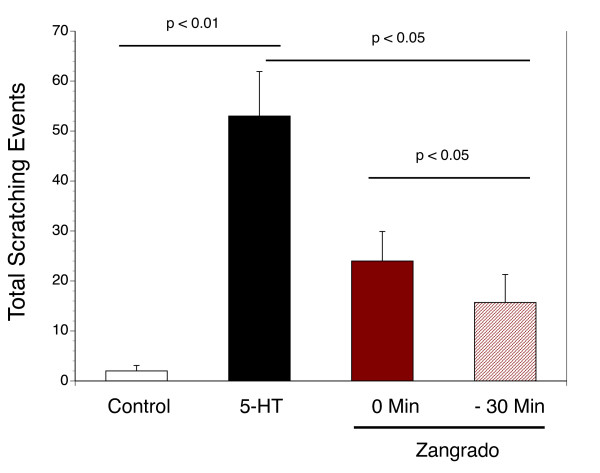
Effects of Zangrado on 5-HT evoked scratching: Comparison between pretreatment and immediate post-treatment. Scratching episodes in response to saline injection (control, n = 5) and 5-HT (black column, n = 11) with vehicle treatment (50 μl of Dermabase crème) or the effects of 50 μl of zangrado (1%) crème applied 30 min (-30 Min column, n = 10) before the sc injection of 5-HT or immediately after (0 Min column, n = 8). The statistical difference between groups is noted in the figure.